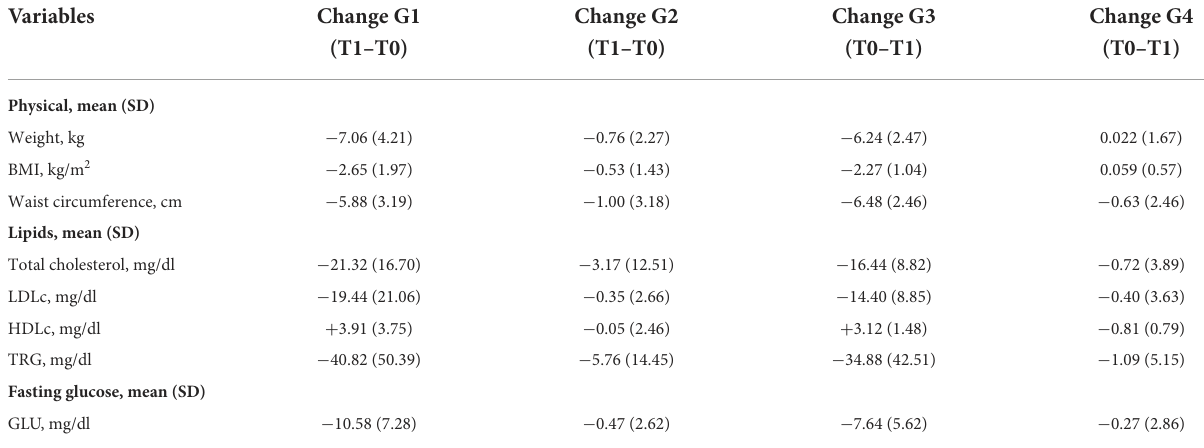
TABLE 3 Mean differences (SD) in anthropometric and metabolic variable changes at the 12-month follow-up (T1) compared to entry into the study